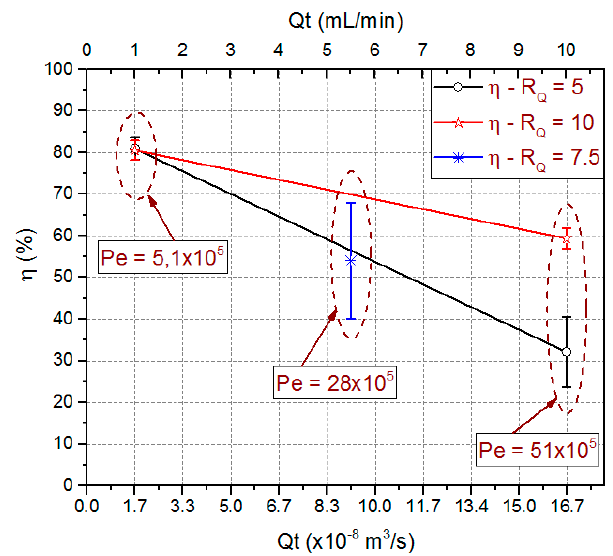
Figure 13. Predicted means values for extraction efficiency and Péclet number for the process variables R Q and Q T . Experimental values obtained for microfluidic device with OD H = 214.63 μ m and L CD = 21.4 mm.